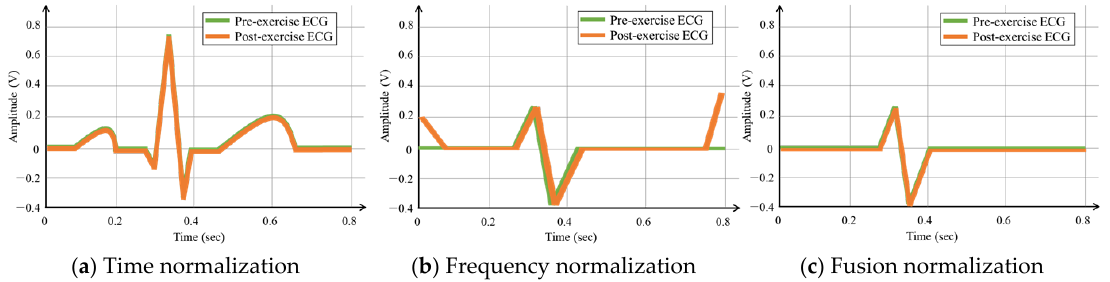
Figure 7. ECG signal cycle in pre- and post-exercise cases as time, frequency, and fusion normalization.